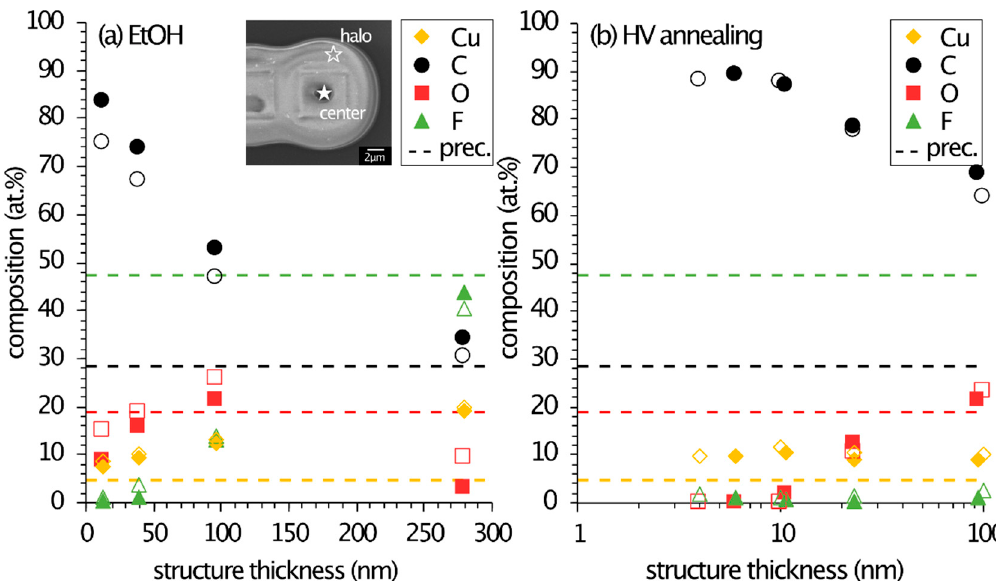
Figure 4. EDX quantification results of the D-EBL structures developed ( a ) in EtOH and ( b ) by annealing HV. The EDX spectra were recorded locally with 3 keV within the structure 8_4 (filled symbols) and in its respective halo (empty symbols). The position of the spectra collection is noted in the inset. Each structure thickness was determined with AFM and correspond to regions I–IV as in Figure 1e. The pristine precursor values are noted for comparison as dashed lines. Note: x -axis in ( b ) is a logarithmic scale. Atomic concentrations have an uncertainty of ±5 at % (not noted in this graph).